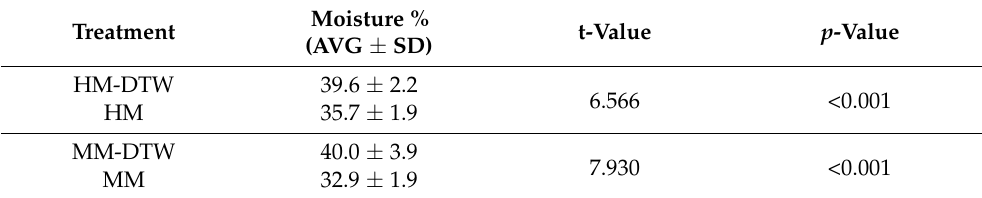
Table 3. Soil moisture values referred to the different conditions analysed and results of the indepen- dent T-test analysis (HM-DTW—areas identified as sensitive by DTW algorithm and harvested with high mechanisation level; HM—areas not identified as sensitive by DTW algorithm and harvested with high mechanisation level; MM-DTW—areas identified as sensitive by DTW algorithm and har- vested with medium mechanisation level; MM—areas not identified as sensitive by DTW algorithm and harvested with medium mechanisation